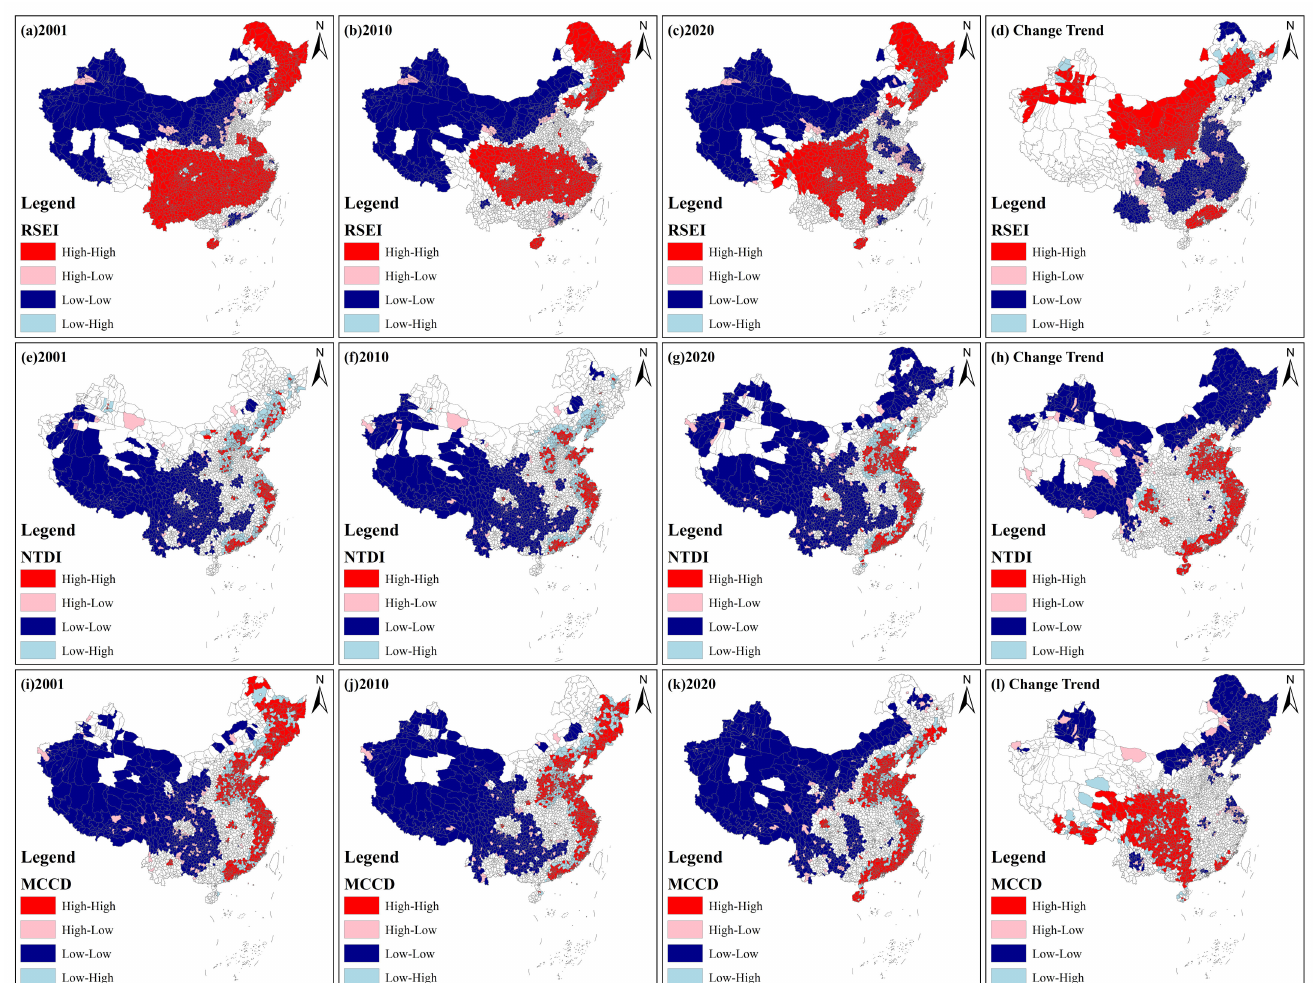
Figure 7. Local Moran’s I spatial distribution of the RSEI, NTDI and MCCD from 2001 to 2020 at the county scale. ( a – c ) display the LISA result of RSEI in 2001, 2010 and 2020. ( e – g ) display the LISA result of NTDI in 2001, 2010 and 2020. ( i – k ) display the LISA result of MCCD in 2001, 2010 and 2020. ( d , h , l ) indicate local Moran’s I change trends of three